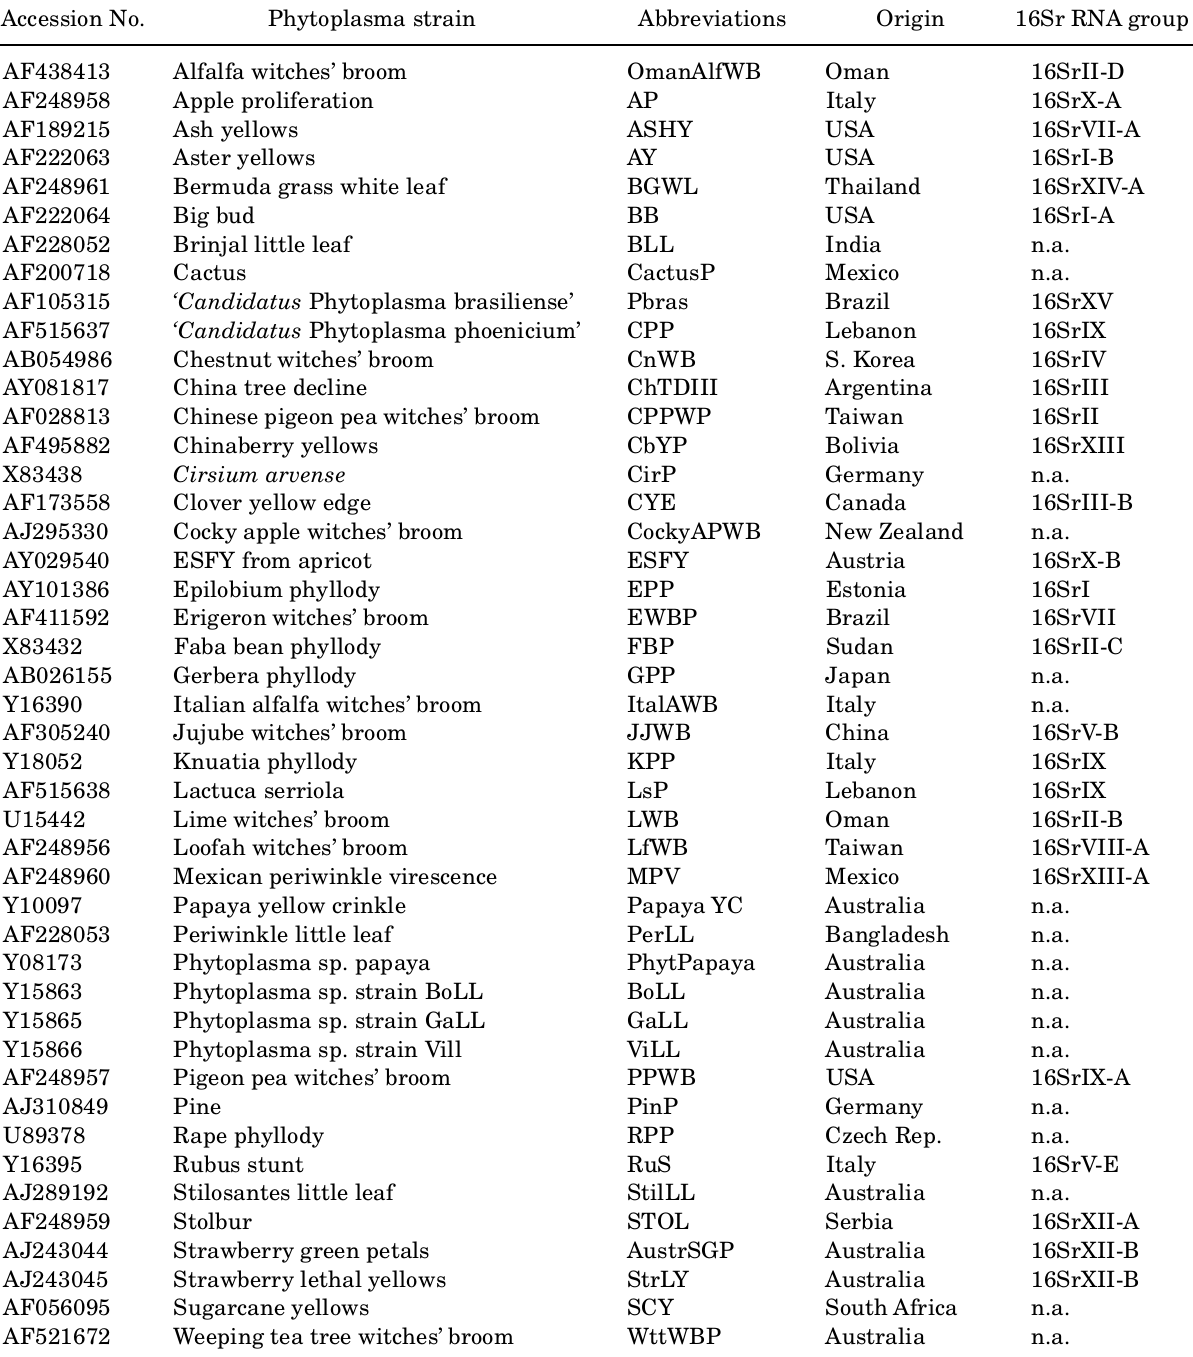
Table 1. 16S rDNA sequences of different phytoplasma strains obtained from GenBank, which were used for phylo- genetic analysis. Accession